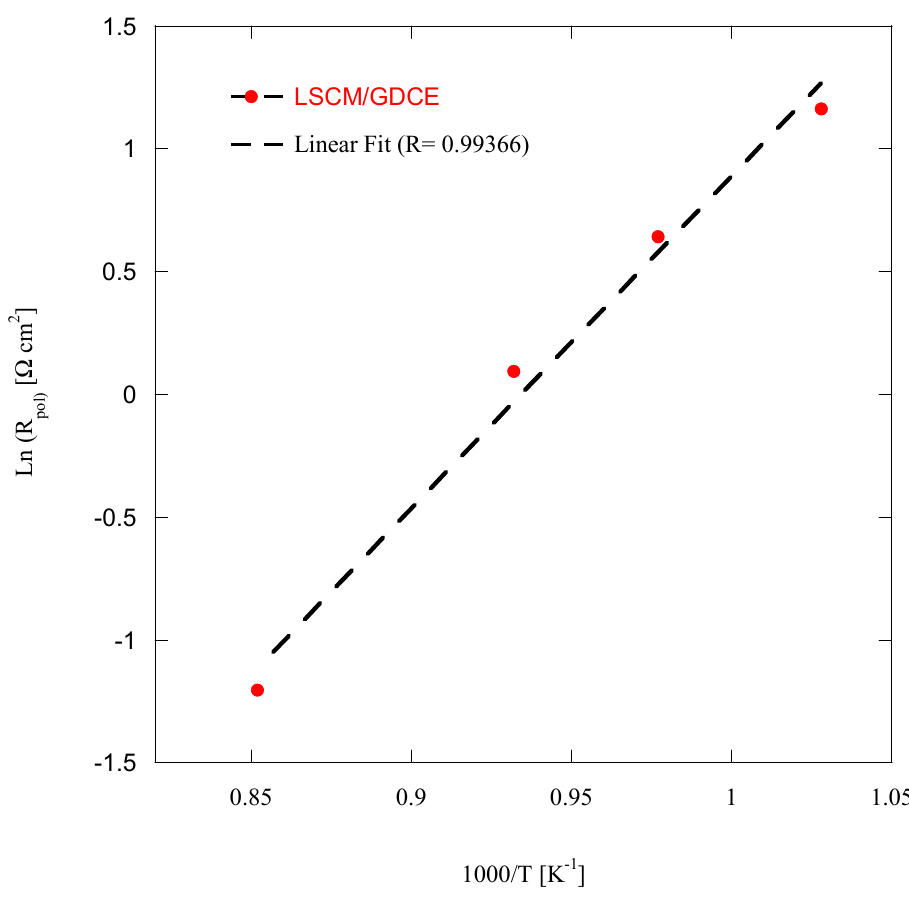
Figure 8. Arrhenius plot (and related linear fitting) of the LSCM/GDCE working with CO/CO 2.